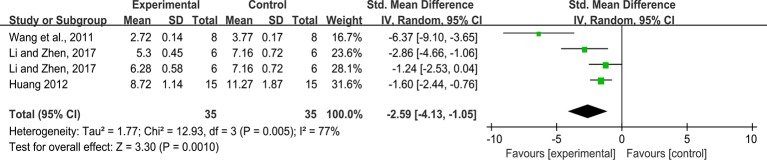
Pooled estimate of MDA with rhein.